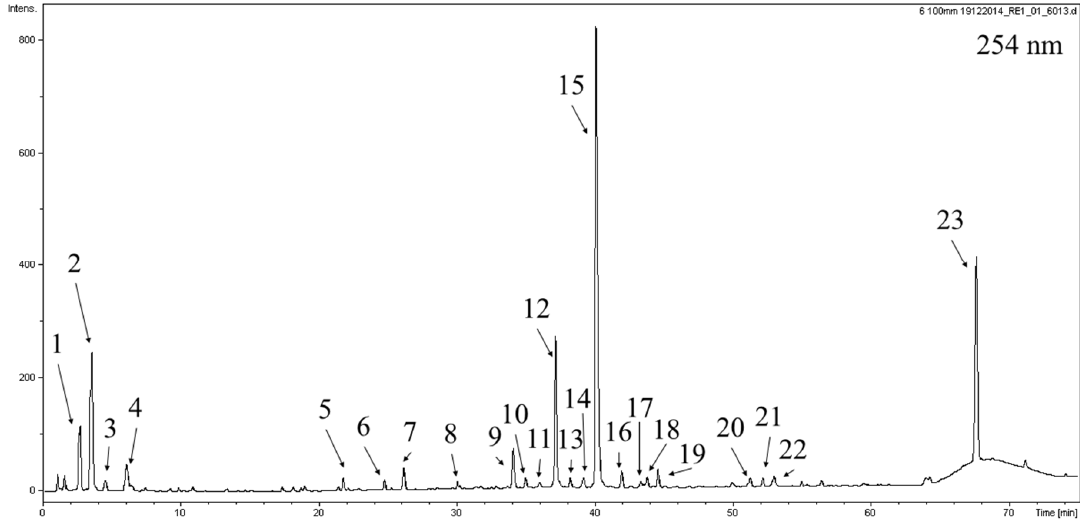
Figure 1. The ultra-high performance liquid chromatography diode array detector (UHPLC–DAD) chromatogram acquired at 254 nm with marked compounds. Peak numbers relate to those in Table 2.